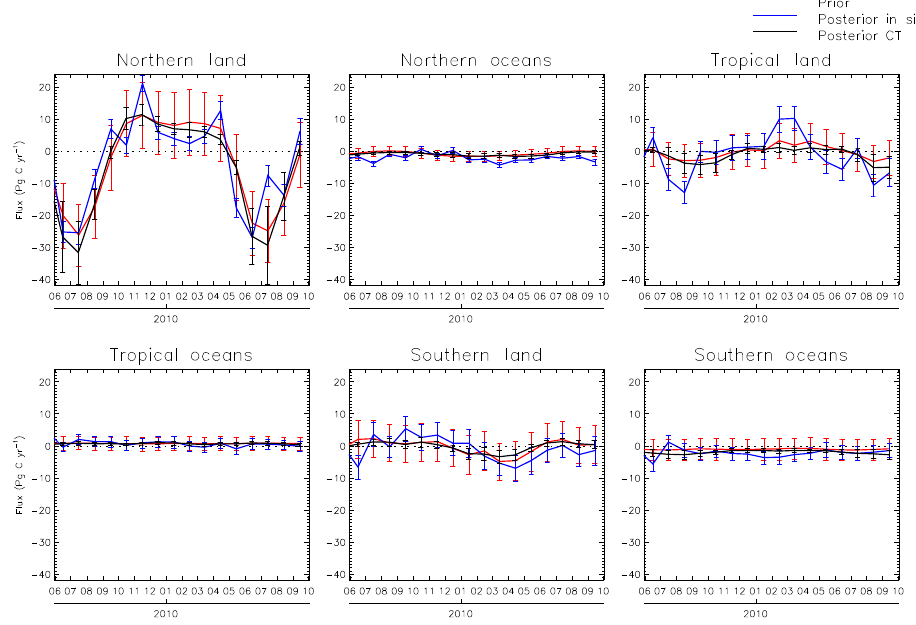
Figure 7. Comparison of our in situ only inversion monthly mean NEP ( ×− 1) and ocean fluxes, aggregated over large regions (as defined in TC3), with posterior fluxes from NOAA’s CarbonTracker (CT2013B) data assimilation system. The priors shown are from our analysis; CT2013B priors are similar. Error bars represent 1 σ